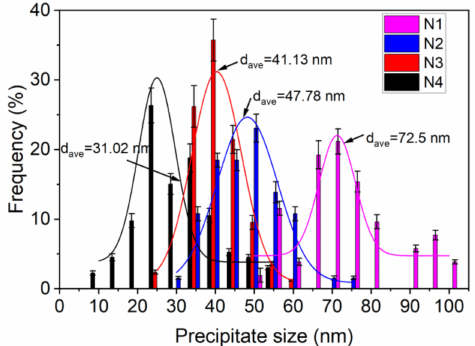
Figure 12. Size distribution of the precipitates in the four kinds of